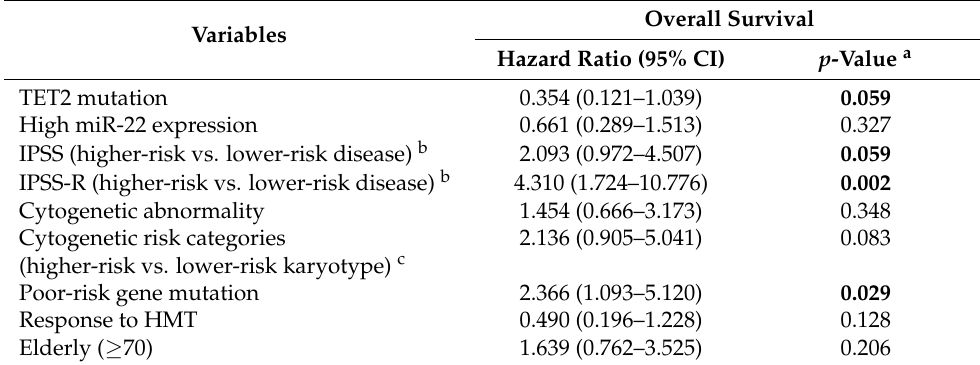
Table 7. Association of various clinical factors with overall survival.